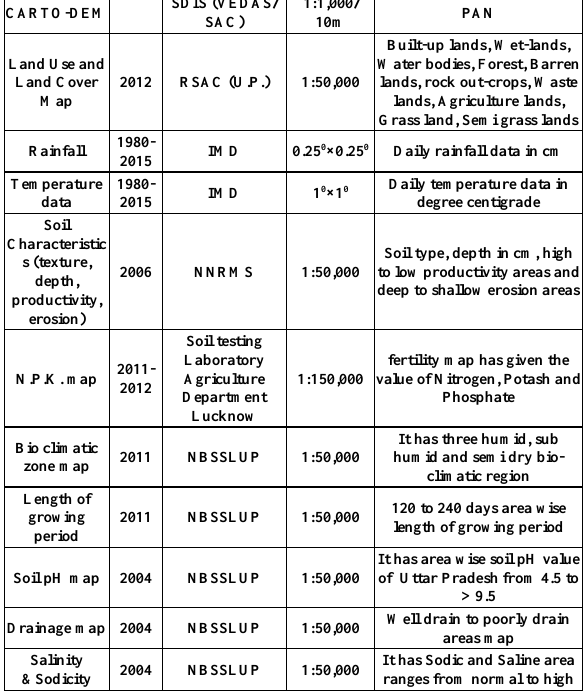
Table 1. Description of datasets